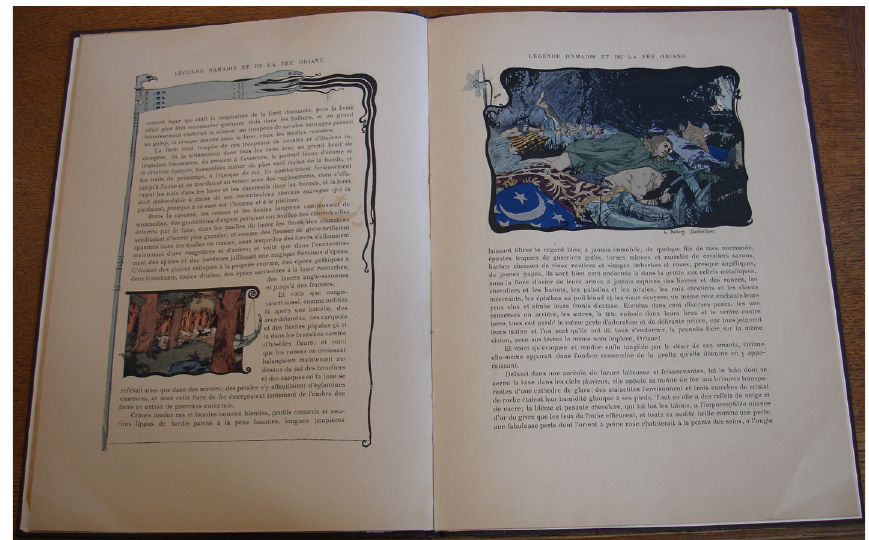
Fig. 6 Jean Lorrain, ‘Légende d’Amadis et de la fée Oriane’ [illustrations by Bellery- Desfontaines], Revue illustrée , no. 254 (1 July 1896), double page, unpaginated. Private